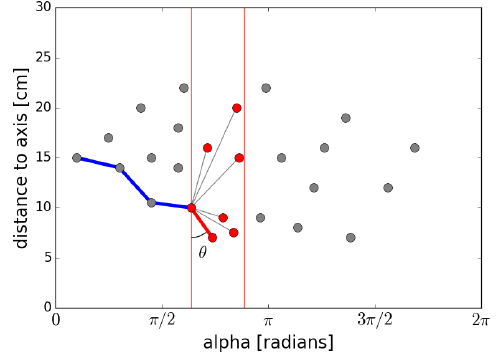
Figure 6. Illustration of the moving window convex hull algorithm designed to find the innermost part of the point dataset. The blue lines are found in earlier iteration steps. The red points are within the current search window. The point that gives the smallest angle θ measured from the y -axis is chosen as the next starting point. The thick red line is the line that is chosen by the algorithm. The thin grey lines are discarded. The search window is then moved to the new starting point for the following iteration steps.